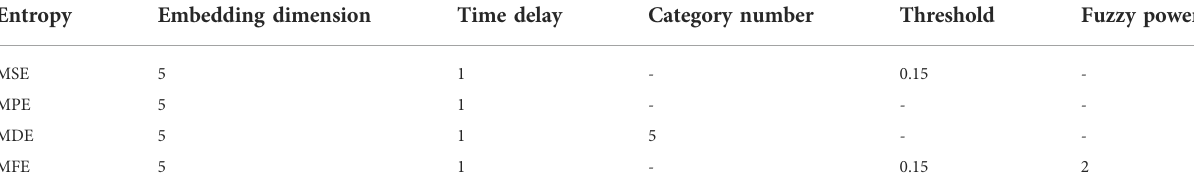
TABLE 1 Parameter settings of four kinds of